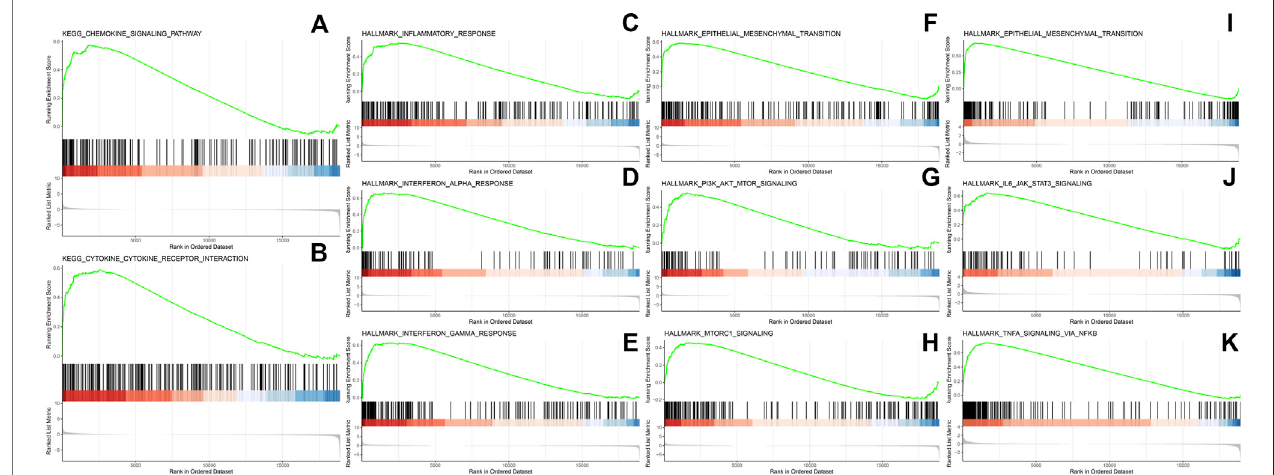
FIGURE7 | GSEA analysisin epithelial cells inresidual tumorsshowingenriched pathways including chemokine signaling pathway (A) ,cytokine-cytokinereceptor interaction (B) , in fl ammatory response (C) , interferon alpha response (D) , interferon gamma response (E) , epithelial mesenchymal transition (F) , PI3K/AKT/MTOR signaling (G) and MTORC1 signaling (H) . GSEA analysis in CAFs in residual tumors showing enriched pathways in epithelial mesenchymal transition (I) , IL6/JAK/STAT3 signaling (J) and TNF α signaling via NF- κ B (K) .